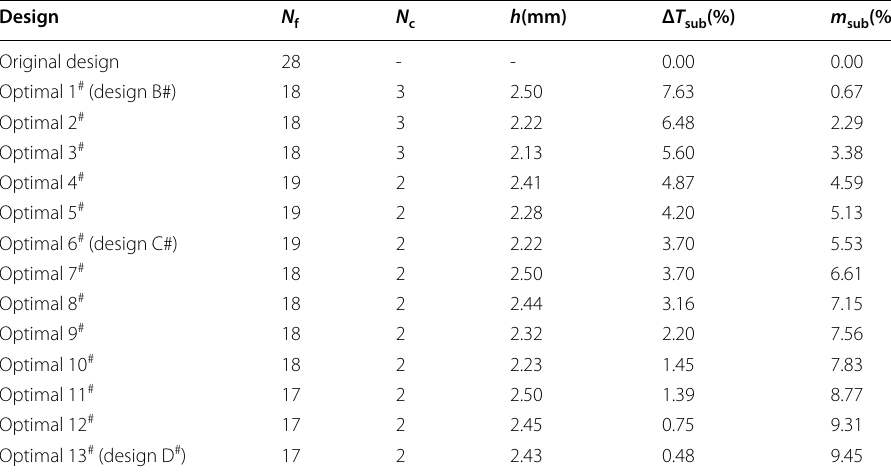
Table 6 The suggested optimal solution set